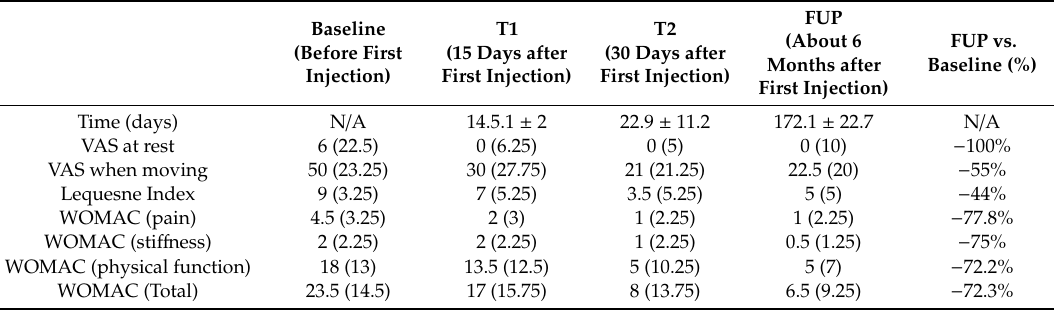
Table 4. Median values at all time points for the parameters under consideration: VAS at rest and when moving, Lequesne index, WOMAC sub scores concerning pain, sti ff ness and physical function and total WOMAC